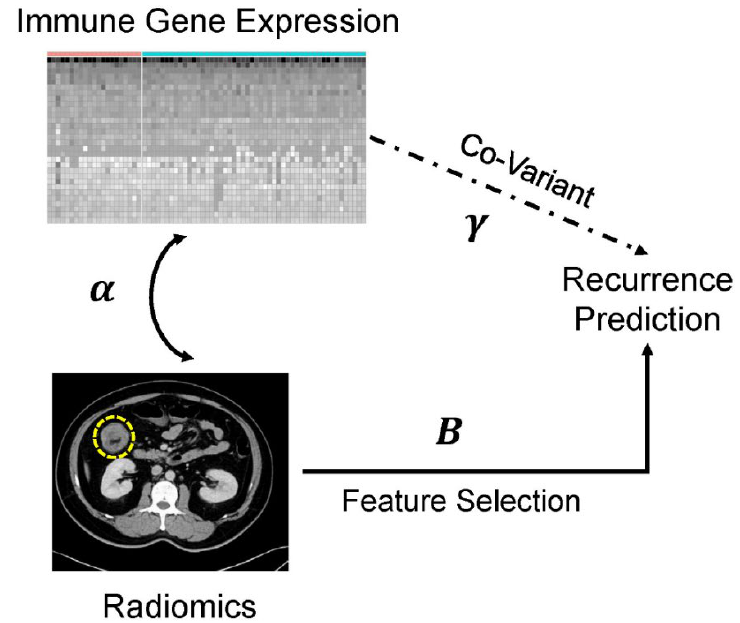
Figure 1. CATCH model for predicting risk of recurrence. The CATCH model can be used to reduce the influence of RNA gene expression covariates in radiomics data. γ represents the discriminative coefficients for the impact of immune gene expression on recurrence. α represents the radiomics parameters indicative of the indirect effect of immune gene expression on cancer recurrence. B represents the direct effect of radiomic features on recurrence in the tensor discriminant analysis .